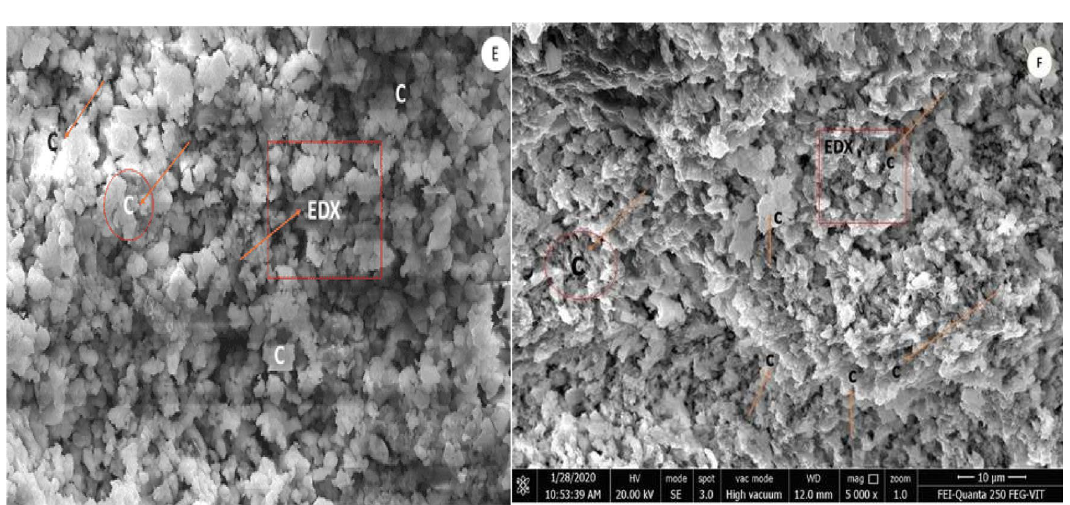
Figure 11. FE-SEM images of modified organic lime paste ( e ).Hibiscus lime paste. ( f ). Reference lime paste. C: Calcite, A;